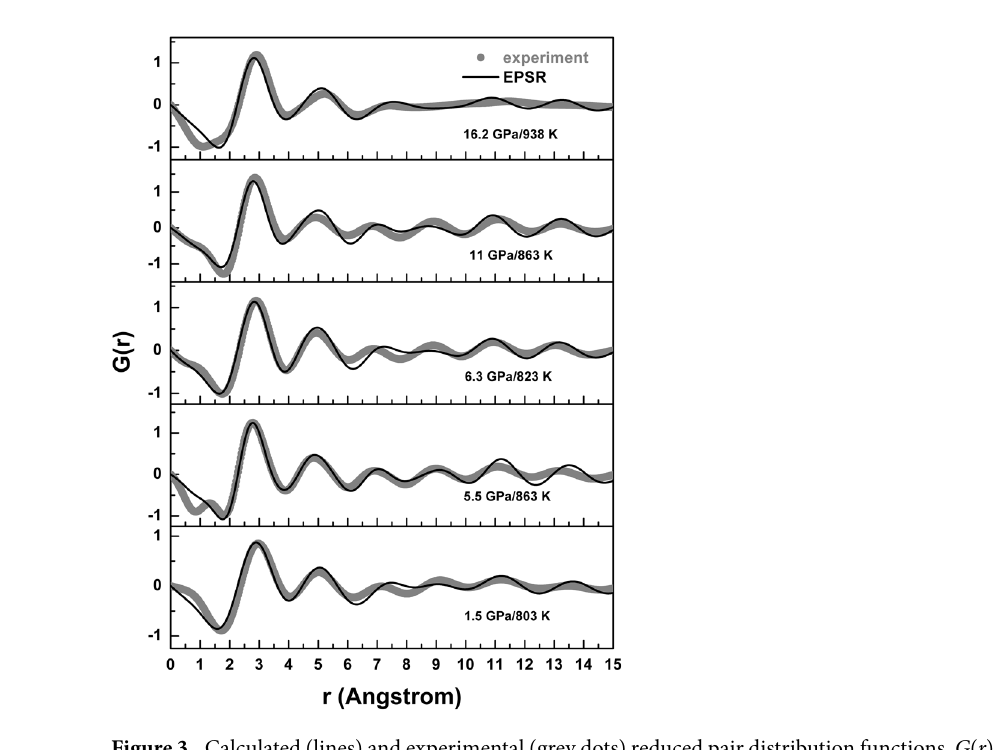
Figure 3. Calculated (lines) and experimental (grey dots) reduced pair distribution functions, G ( r ), for liquid AuGa 2 under